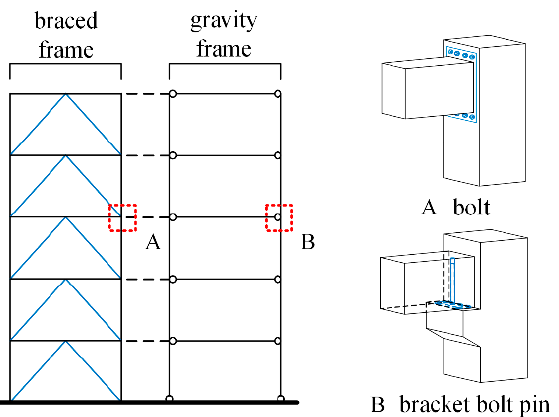
Figure 10. Sketch of PCF-BRB connections.